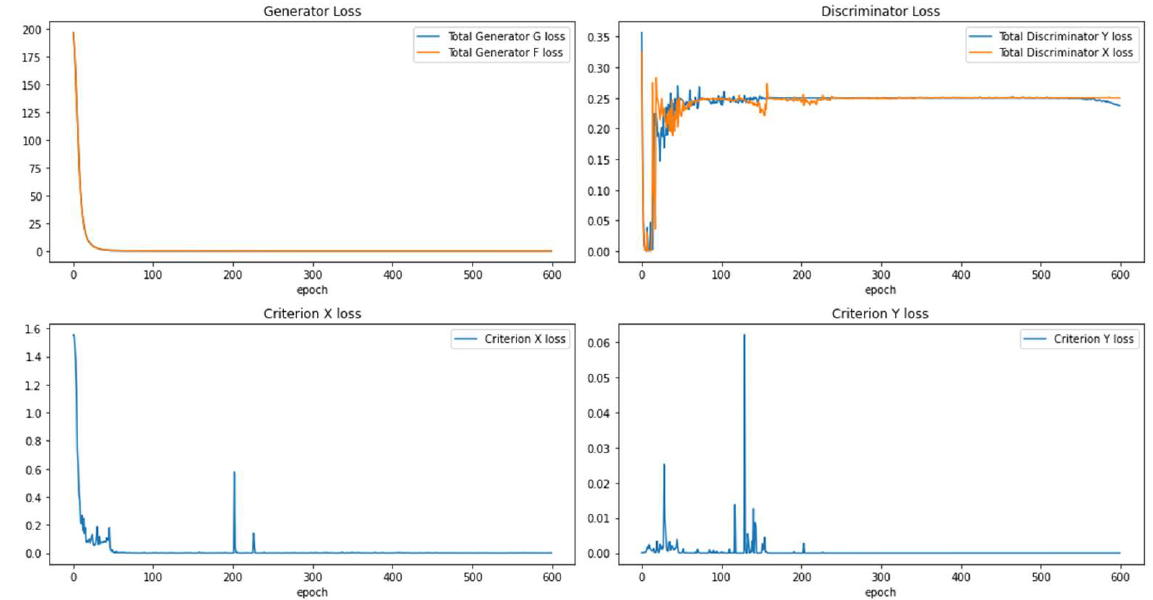
Figure 5. Optimization process of Ad CycleGAN.